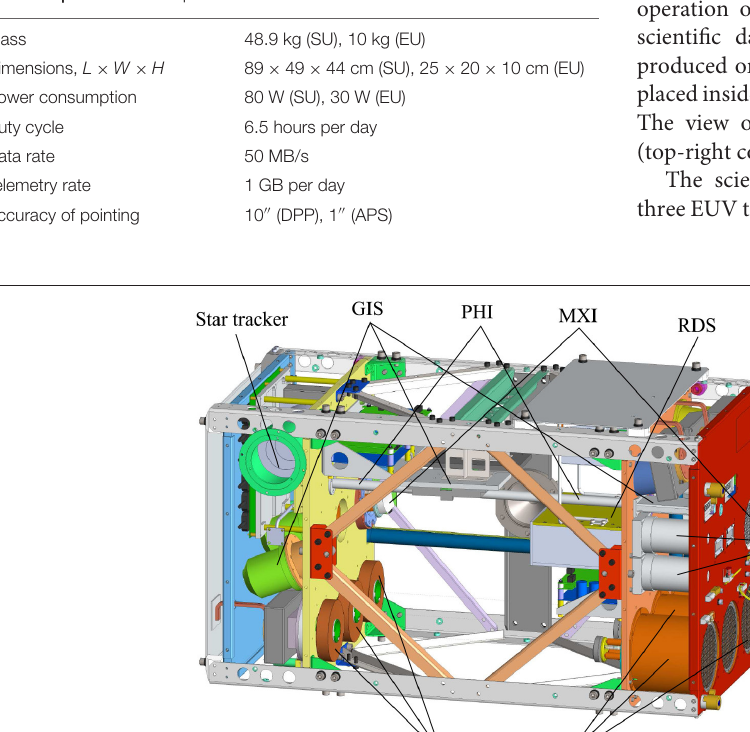
TABLE 1 | Main technical parameters of KORTES.